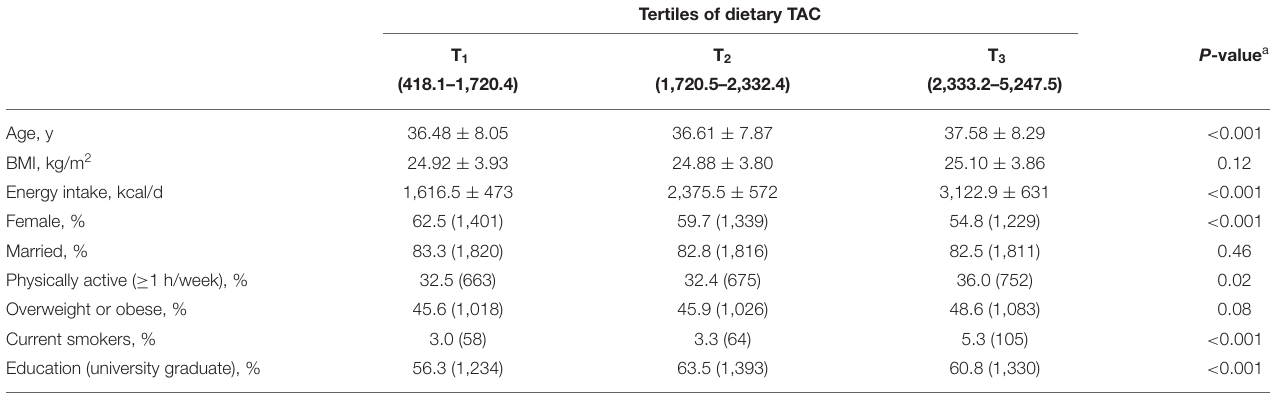
TABLE 1 | General characteristics of study participants across tertiles of dietary TAC.